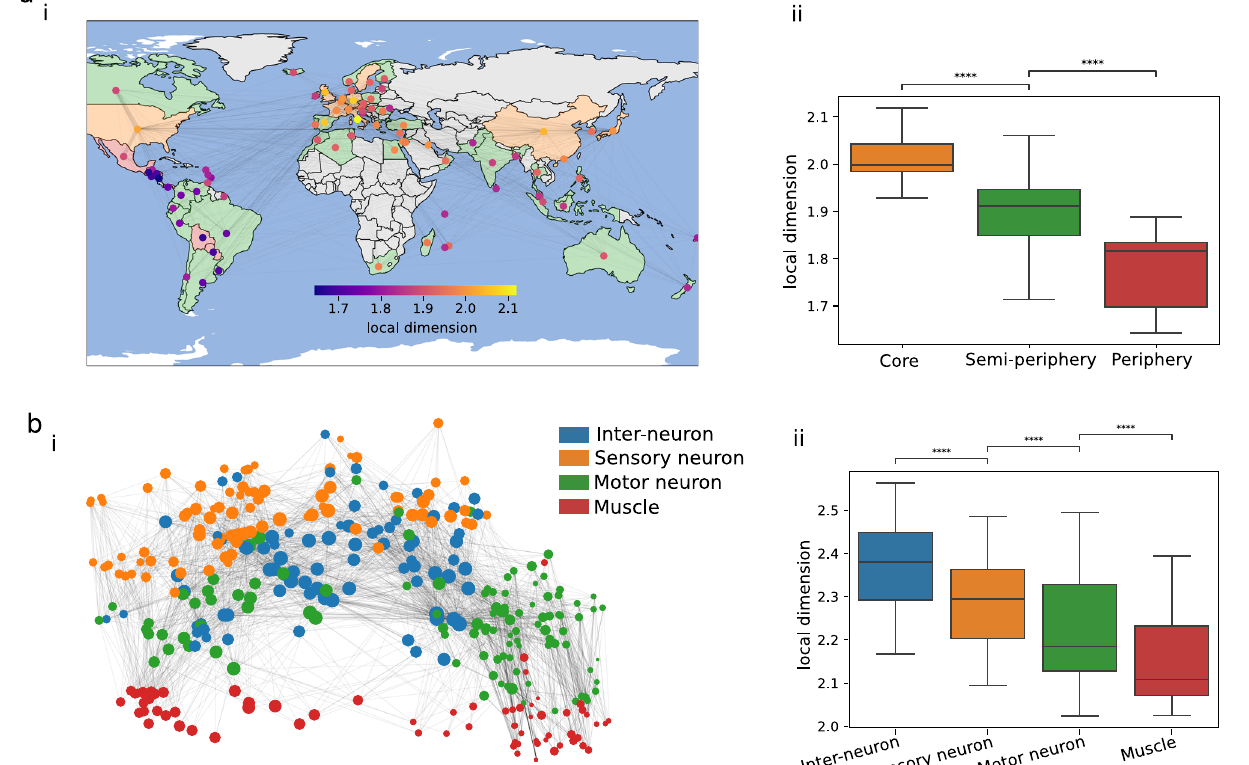
Fig. 5 Spatially embedded networks with long range interactions. a i The local dimension (coloured nodes) of the 1994 world trade dataset 24 ( τ = 0.57). Countries are coloured according to their position in the world partition (grey countries not in dataset). ii Comparison of local dimension by world partition shows a decreasing local dimension as the countries become more peripheral. b The C . elegans connectome consisting of 279 neurons and 98 muscles coloured by neuron type/muscle are shown in i . In ii , the boxplots of local dimensions at large scale show that the neuron types statistically differ. All statistical tests were Mann – Whitney – Wilcoxon test two-sided with Bonferroni correction, **** p ≤